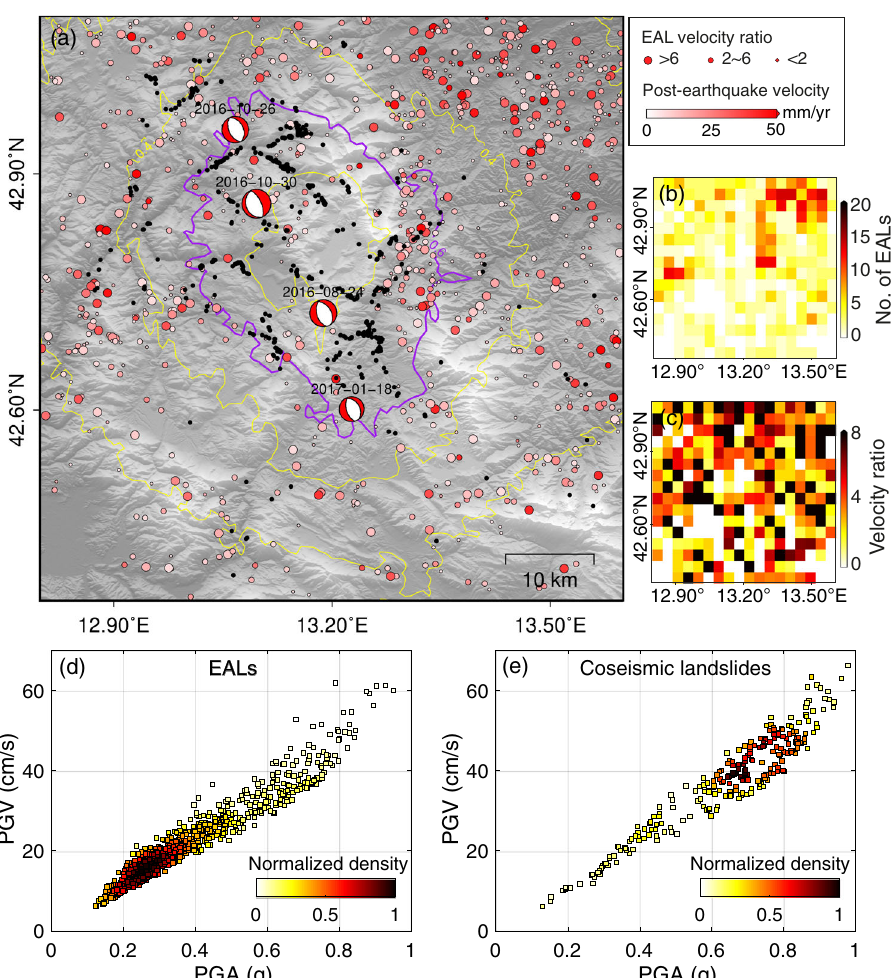
Fig.3|DistributionofEarthquakeAcceleratedLandslides(EALs)andcoseismic landslides and their relationships with Peak Ground Acceleration/Velocity (PGA/PGV). a Postearthquake deformation velocity of EALs and the EAL velocity ratio. Solid lines indicate the cumulative PGA contours of the four earthquakes, where the purple contour shows 0.6g PGA. Black dots are coseismic landslides